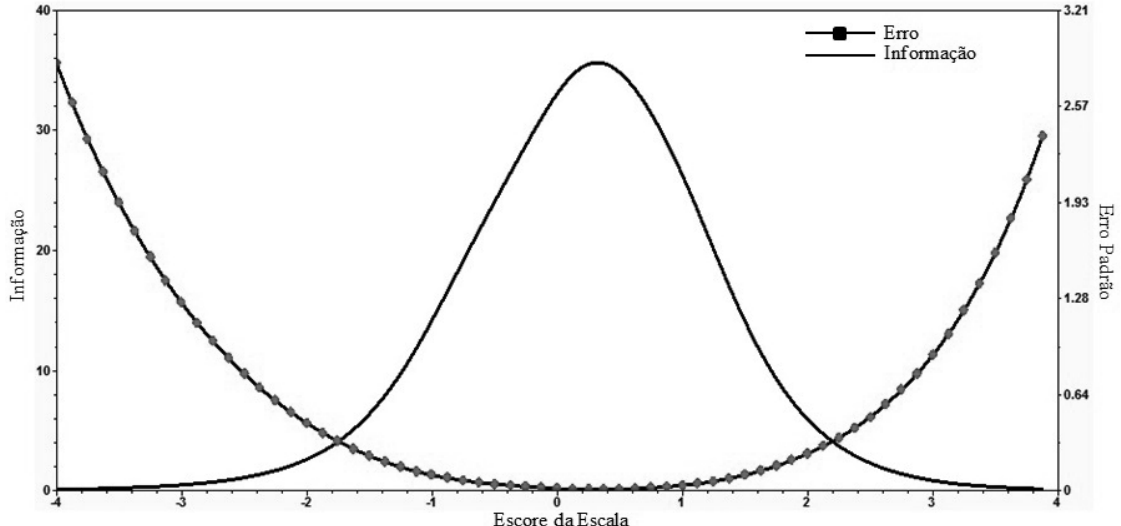
Figura 1 . Curva de informação e erro padrão de medida produzida pelo conjunto de itens ao longo do nível de habilidade de